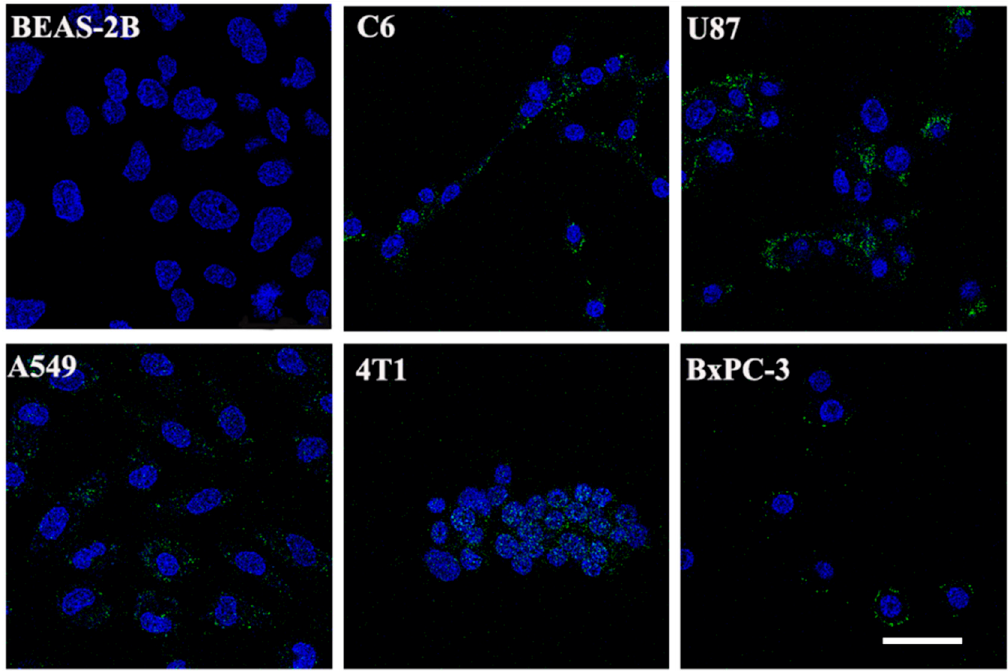
Figure 3. Confocal microscopic images of six types of cells treated with 10 µM FITC-PTP for 4 h. The scale bar represents 50 µm for all panels.